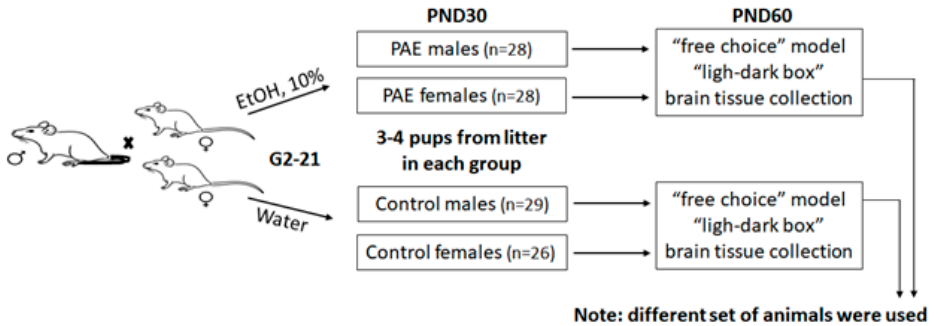
Figure 1. Scheme of the experimental design. EtOH—ethanol. PAE—prenatal alcohol exposure. PND—postnatal day.